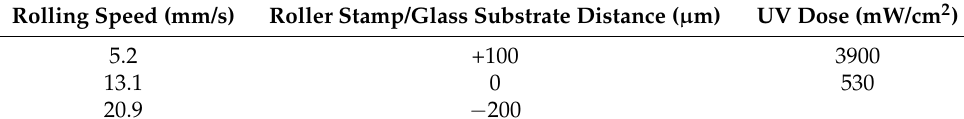
Table 3. The processing parameters used for roller embossing of nanofeatured films.